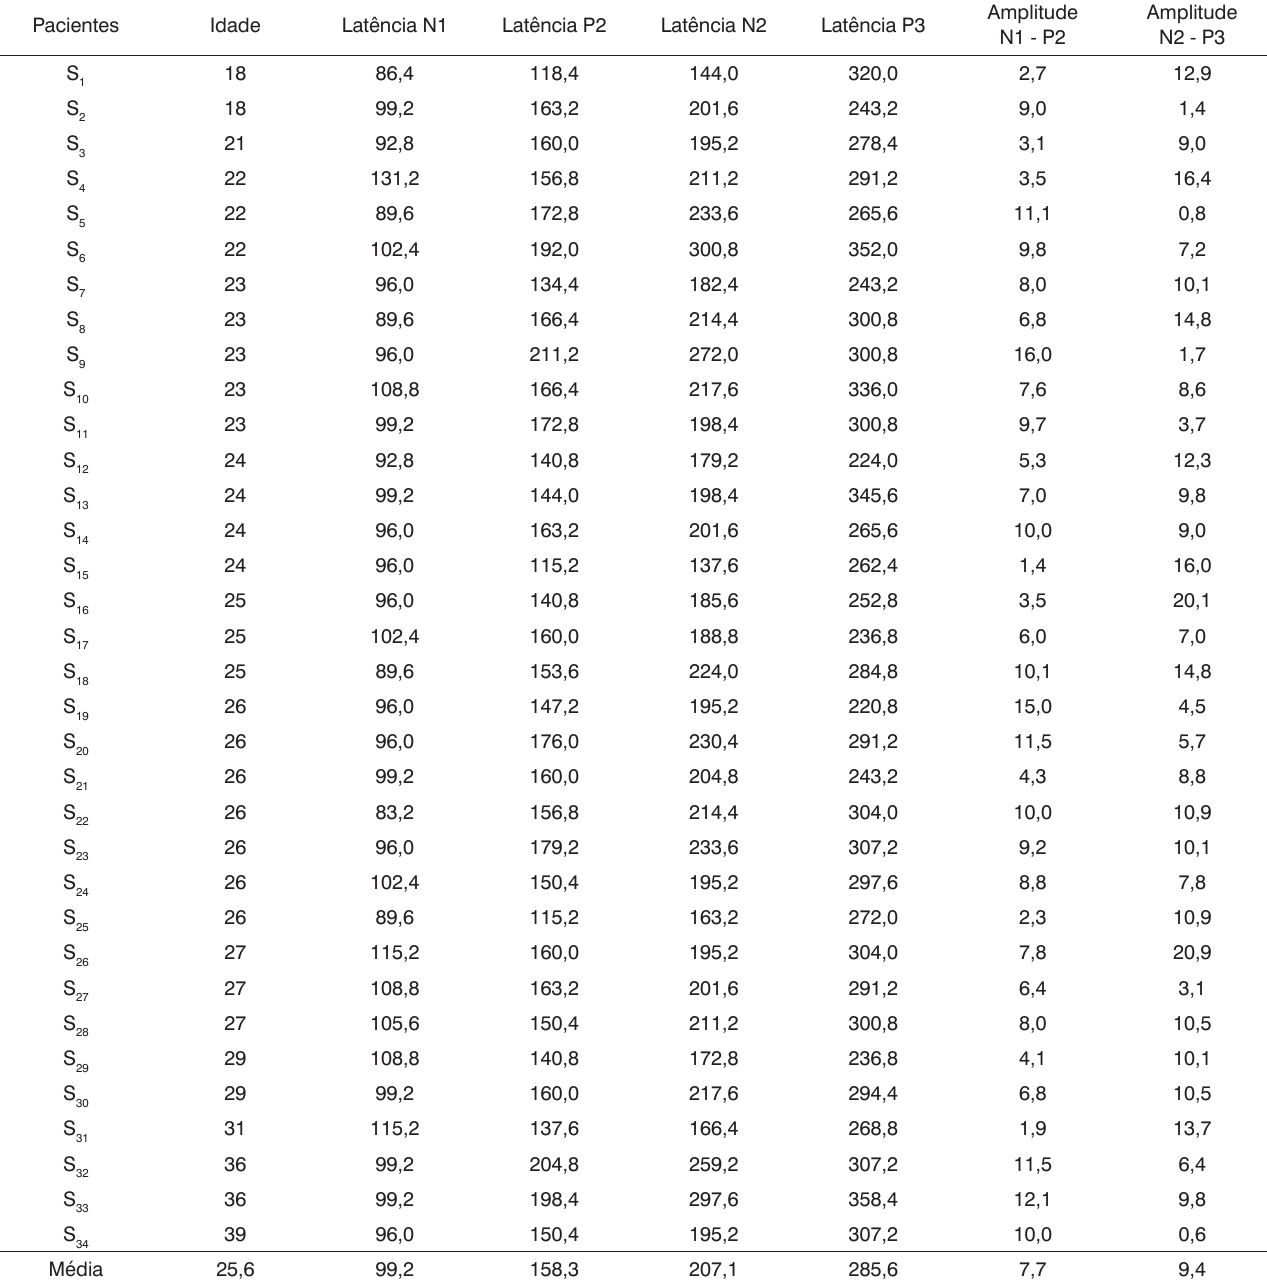
Tabela 2. Valores das latências N1, P2, N2 e P3 e amplitudes N1- P2 e N2 - P3 dos 34 indivíduos saudáveis do grupo